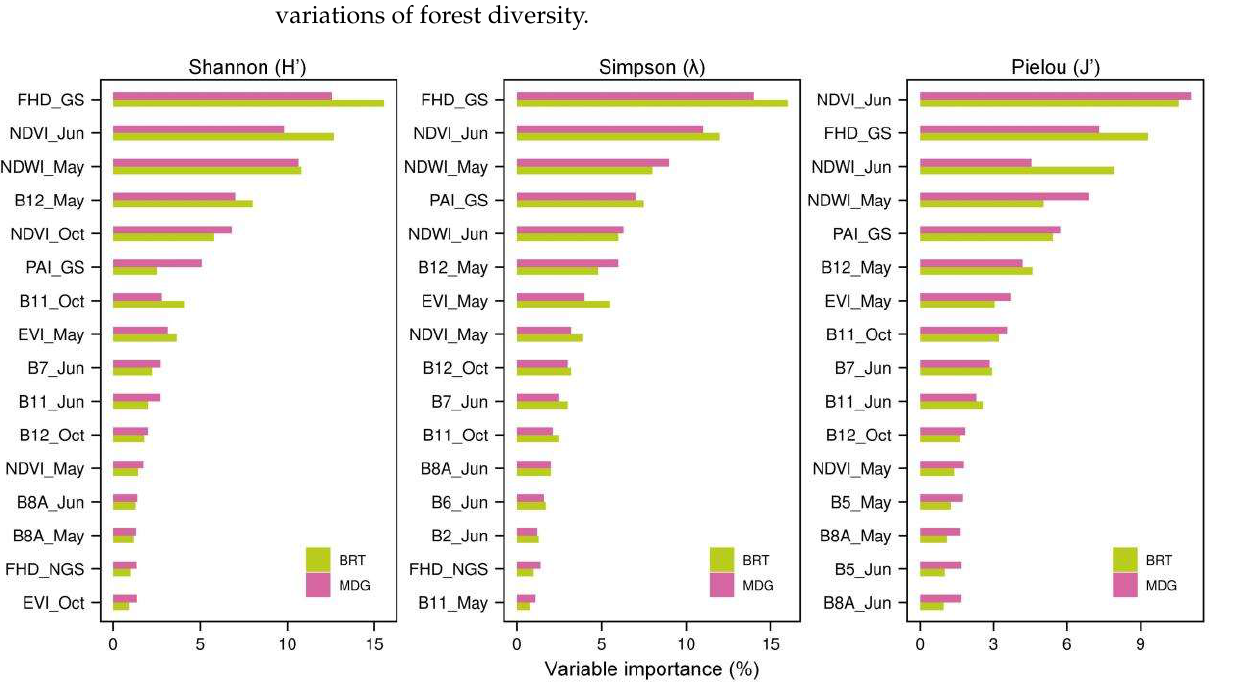
Table 5. Estimated accuracy for different data combinations in three diversity